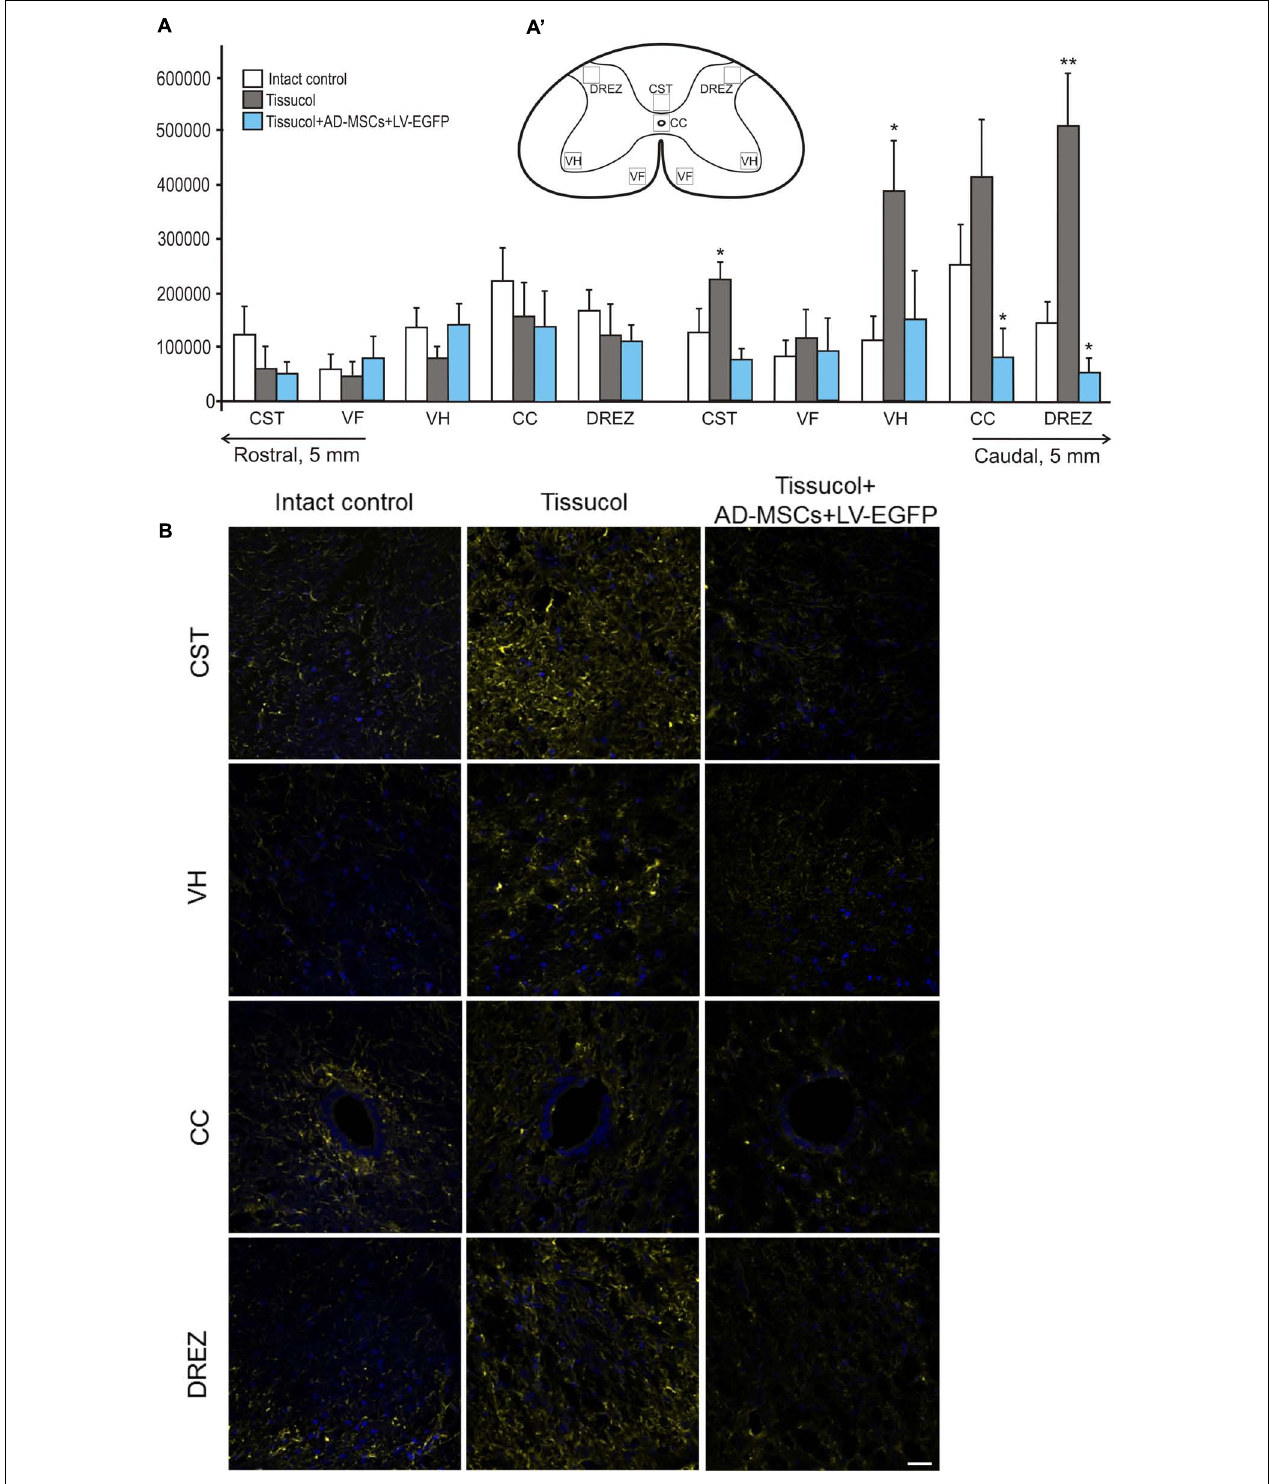
FIGURE 3 | Astroglial activation at the site of injury. (A) The mean intensity of GFAP (Y axis) in intact spinal cord (write column) or 60 days after Tissucol (gray column) and Tissucol+AD-MSCs+LV-EGFP (blue column) application in the examined regions. ∗ P < 0.05, ∗∗ P < 0.01, one-way ANOVA followed by a Tukey’s post hoc test. (A’) In the rat spinal cord, five areas were selected for immunohistochemical evaluation: the ventral horn (VH), the main corticospinal tract (CST), the ventral funiculi (VF), the area of the central canal (CC) and the dorsal root entry zone (DREZ). (B) Visualization of astroglial activation using GFAP (yellow) 5 mm caudally from the injury epicenter within the CST, VH, CC, and DREZ in the investigated groups. Nuclei are DAPI-stained (blue). Scale bar: 25 µ m.